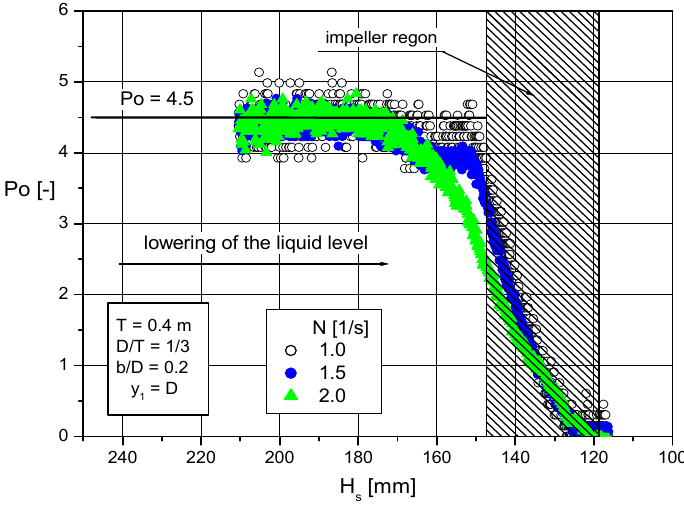
Figure 9. Change in the power number Po for a radial impeller.